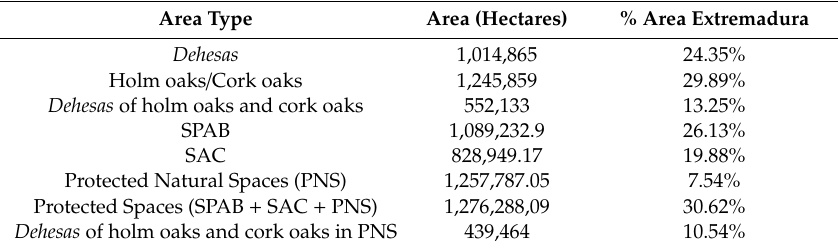
Table 1. GIS design